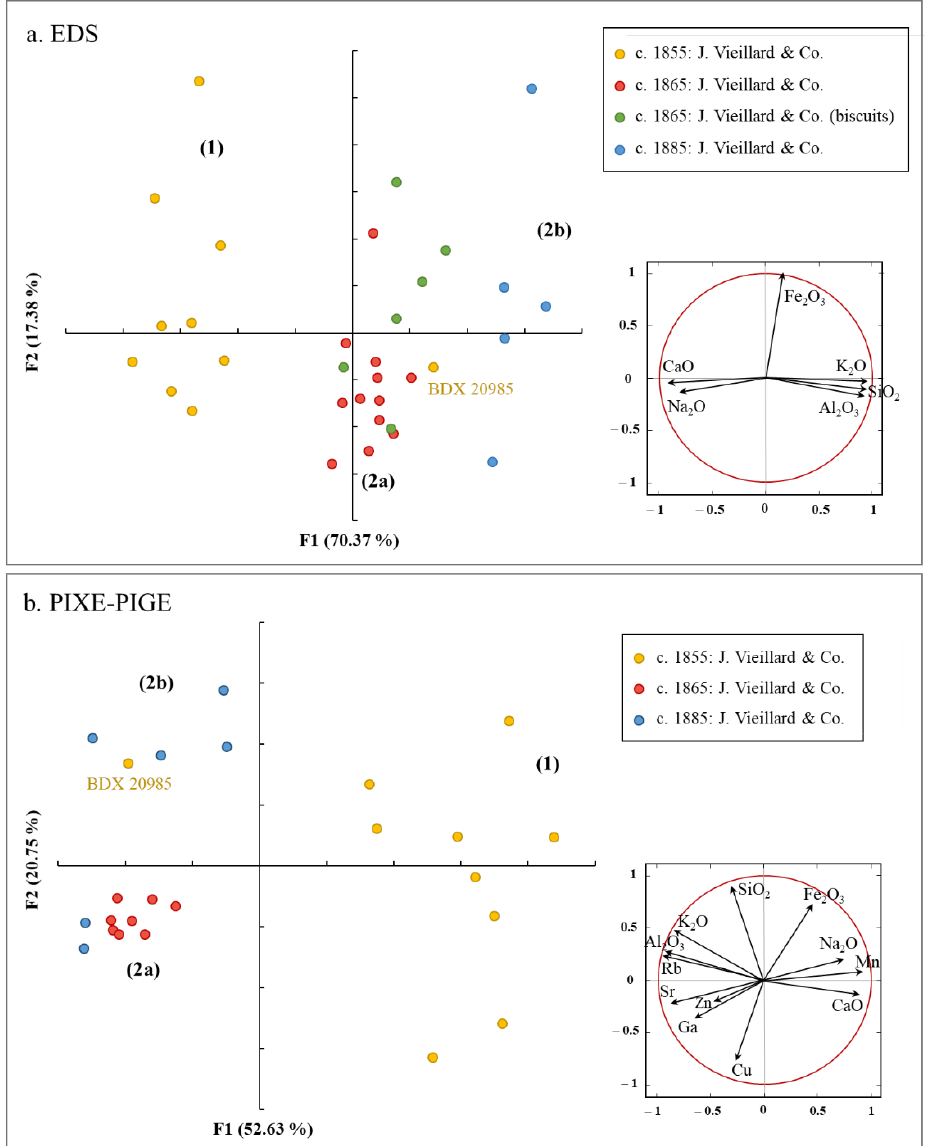
Figure 5. PCA score/loading plot obtained with ( a ) EDS and ( b ) PIXE-PIGE data of some detected elements of the porcelain bodies.